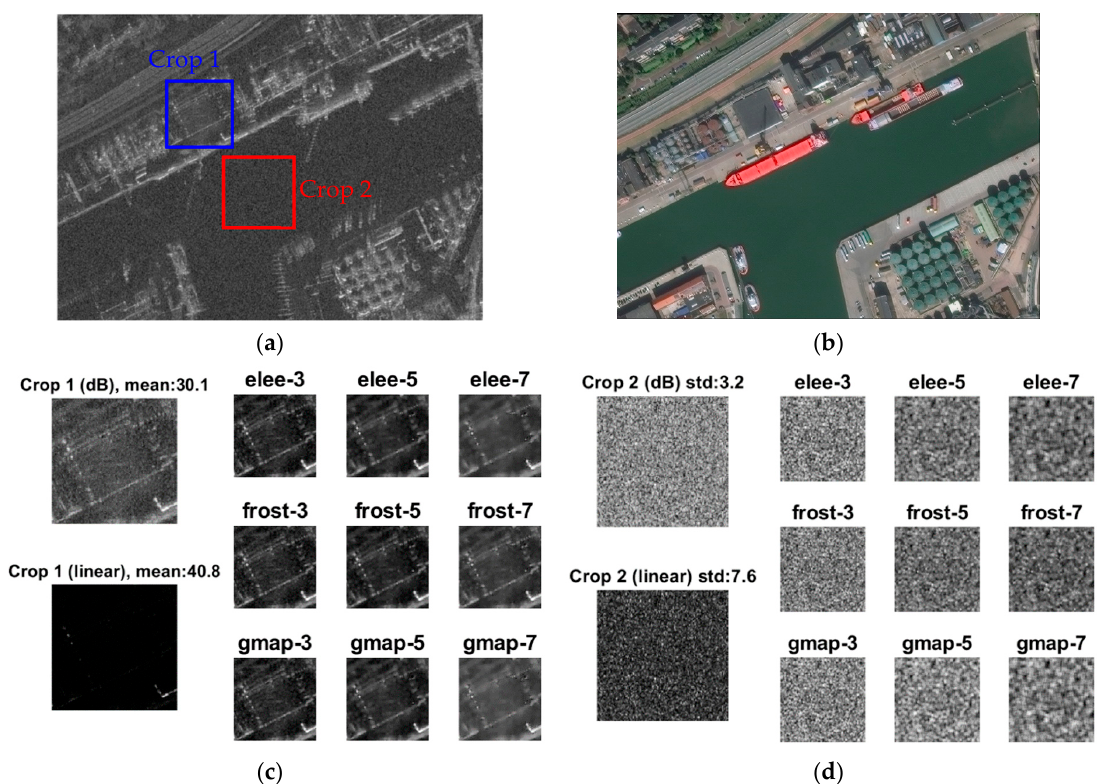
Figure 12. A sample SAR Log Intensity (dB) Image ( a ) with its equivalent optical RGB ( b ). We further analyze two distinct crop regions of a building (crop 1) and a homogenous water area (crop 2). The results of filtering with selected speckle filters and various kernel sizes are given in ( c , d ). The image in linear scale appeared dark because of the wide dynamic range. Table 1. Quantitative comparison of the applied filters. The mean, standard deviation (std), and Equivalent Number of Looks (ENL) are calculated in the linear scale.